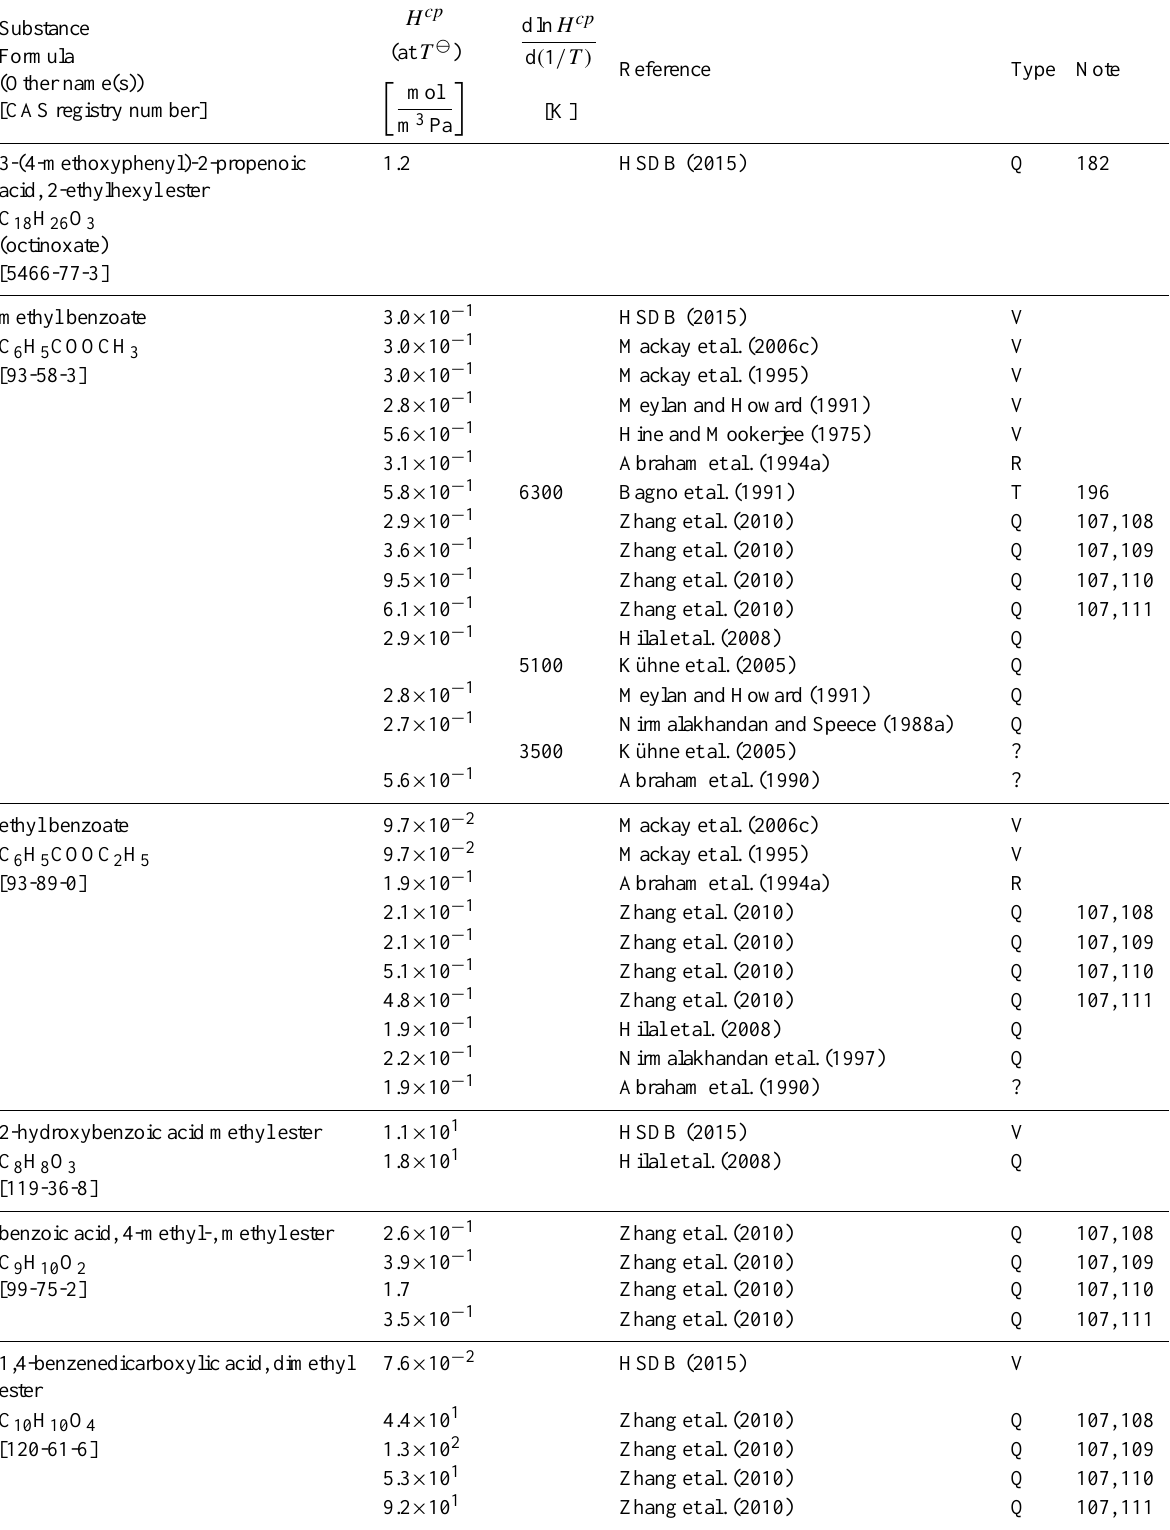
Table 6: Henry’s law constants for water as solvent